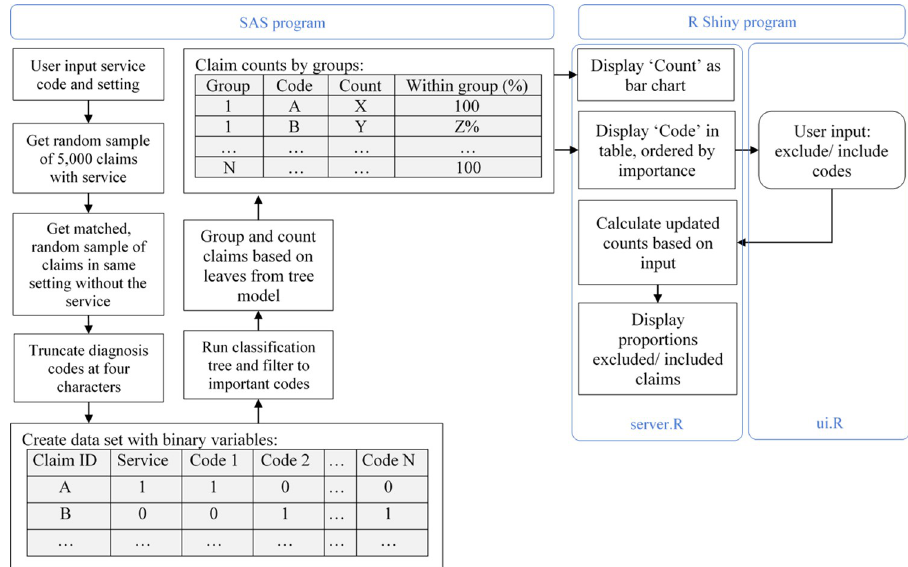
Fig 1. The data processing steps in 1) SAS and 2) R Shiny (in the server and user-interface [ui] scripts).